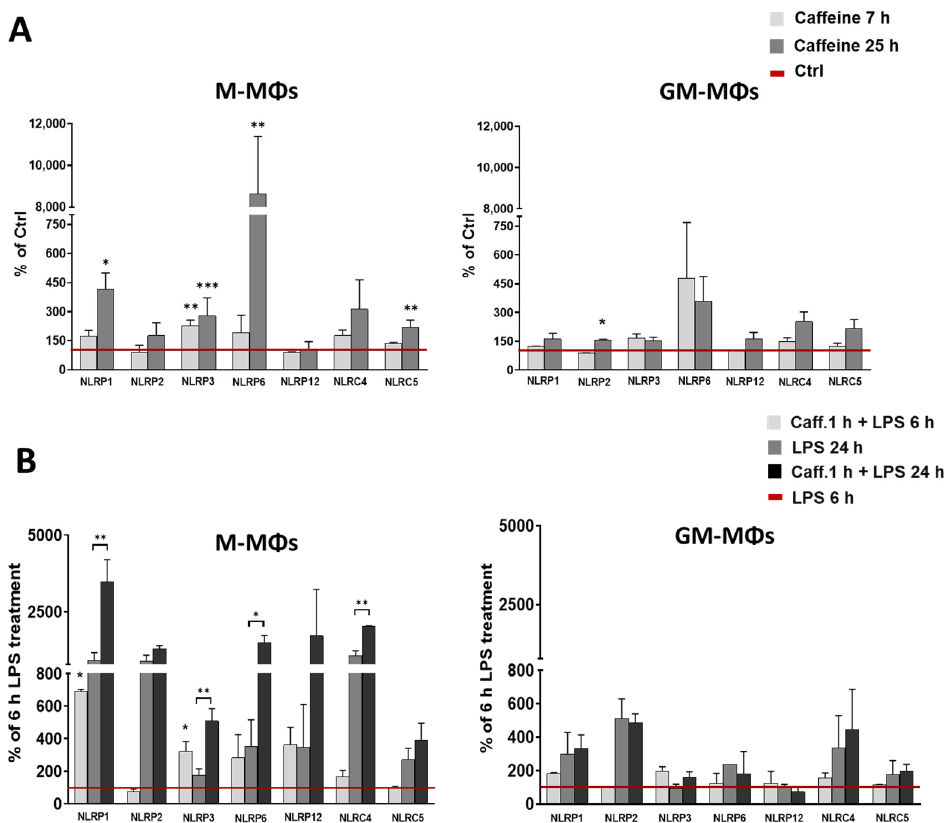
Figure 2. Effects of caffeine on NLRs expression in M-M Φ s and GM-M Φ s. The relative gene expression of indicated genes was measured by qPCR. ( A ) Cells were treated with caffeine (1 mM) for different time points. ( B ) Cells were pre-incubated with caffeine (1 mM) for 1 h, then primed with LPS (100 ng/mL) for the indicated time. Cyclophilin (Cyclo) was used as reference gene to normalize the gene expression. All results are shown as means ± SEM. (* p < 0.05, ** p < 0.01, *** p < 0.001).